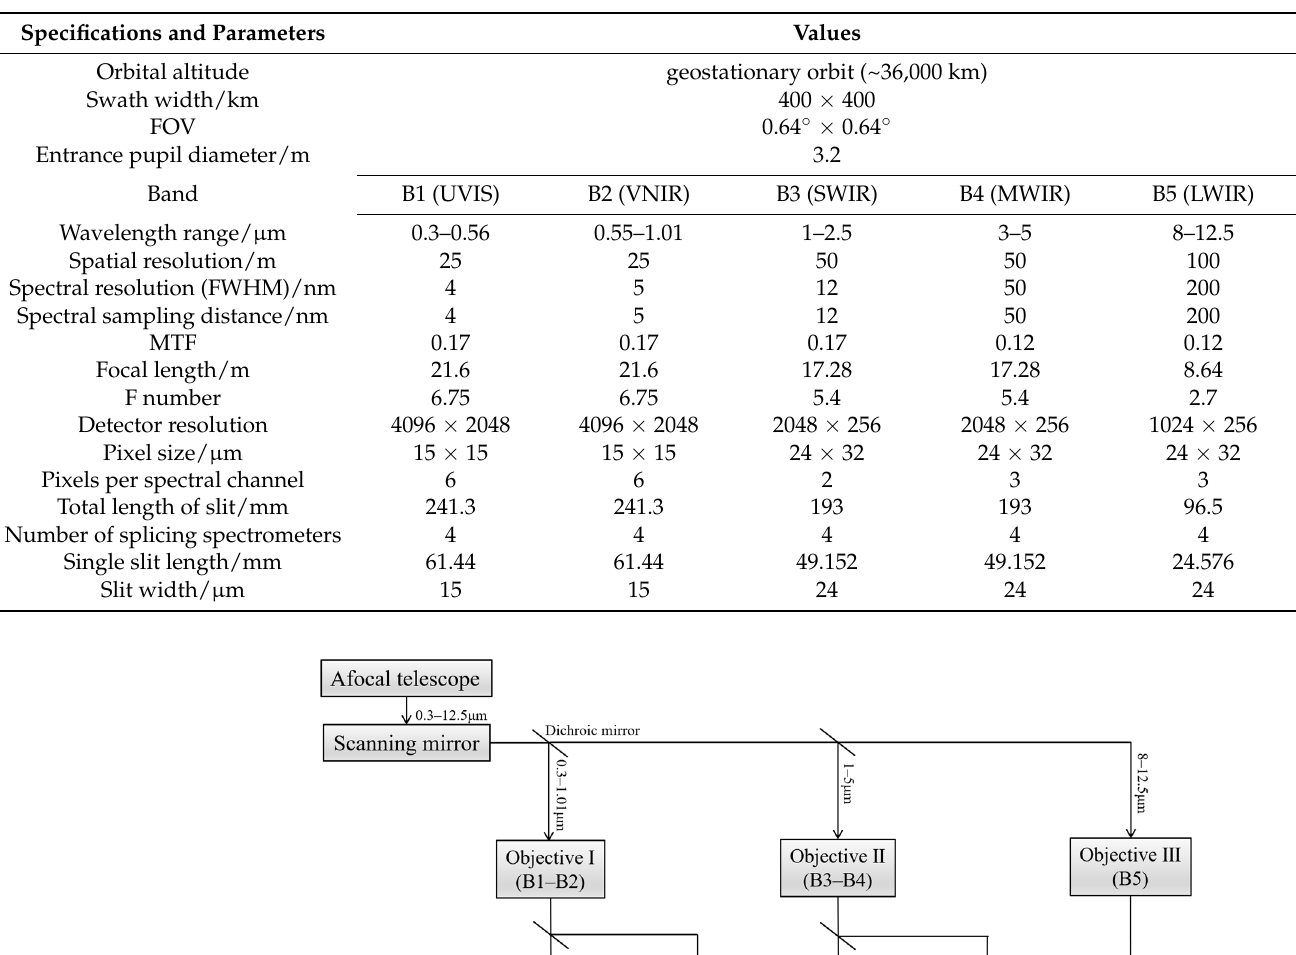
Table 1. Specifications and system parameters of GeoFWHIS.